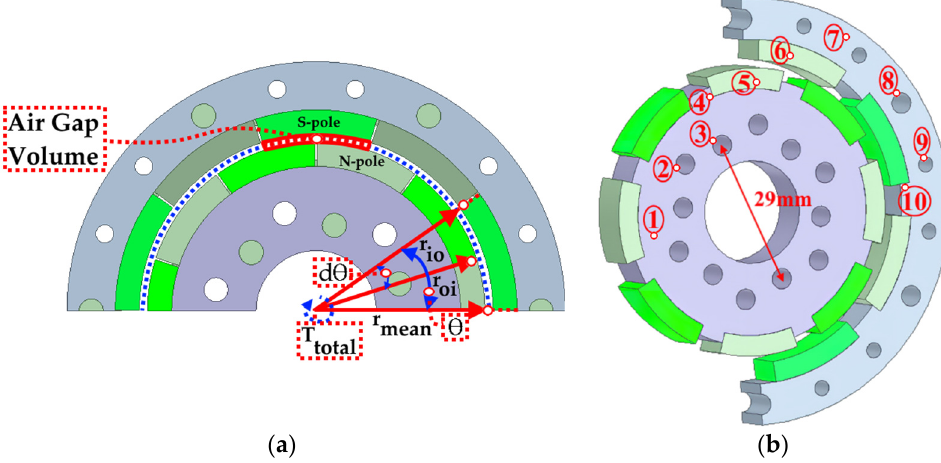
Figure 6. Model of the MCs ( a ) Parameter definitions for the VM method; ( b ) Material definitions.